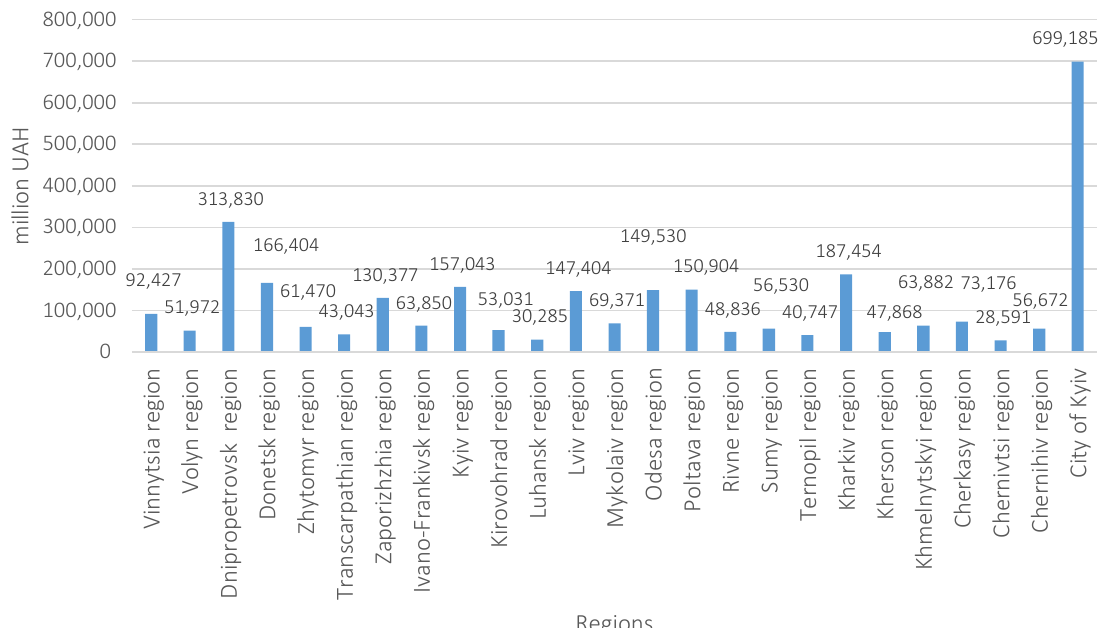
Source: State Statistics Service of